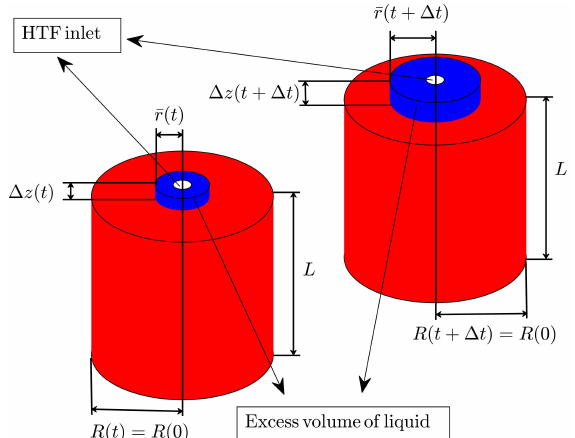
Figure 1. Schematic representation of liquid volume growth in the axial direction. The height of the column that represents the excess liquid at any time t is ∆ z ( t ) . The volume of this liquid at some time (cid:0) (cid:1)(cid:0) t is ∆ V (cid:96) ( t ) = r ( t ) 2 − r 2 L + ∆ z ( t )) and represents the liquid that will scatter throughout the top 0 surface of the cylinder or the volume of liquid that must be removed from the cylindrical